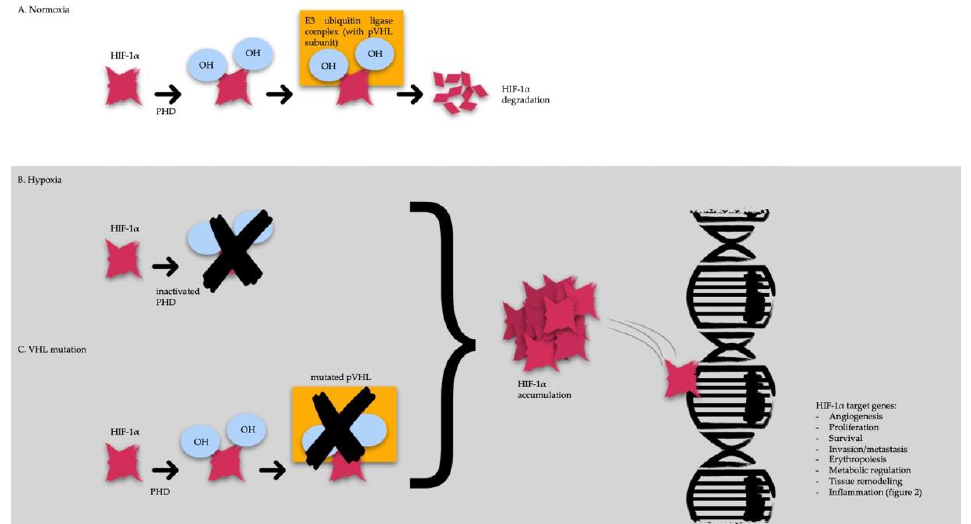
Figure 1. HIF-1 α and pVHL function under different conditions: ( A ) in normoxic conditions, HIF-1 α is hydroxylated by PHD, bound by the VHL protein complex, and destroyed by the S26 proteasome; ( B ) in hypoxic environments, the inactive PHDs don not hydroxylate HIF-1 α , which results in protection from ubiquitination, and hence it tends to accumulate; ( C ) when pVHL is mutated, as in VHL disease, the E3 ubiquitin ligase complex does not work, and HIF subunits accumulate. When HIF-1 α levels increase, it modulates the transcription of several genes. pVHL, VHL protein; HIF-1 α , hypoxic-inducible factor; PHD, prolyl